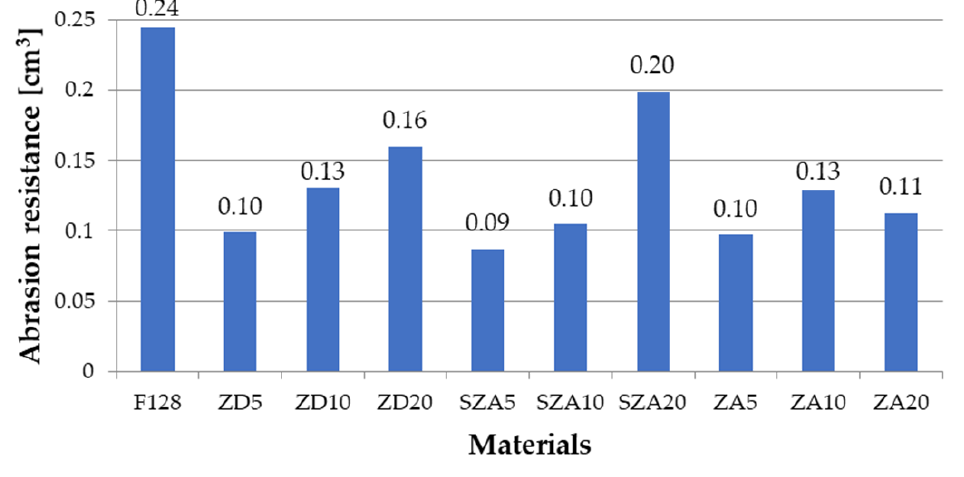
Figure 8. Abrasion resistance of the tested materials. Table 6. Abrasion resistance of the tested materials.